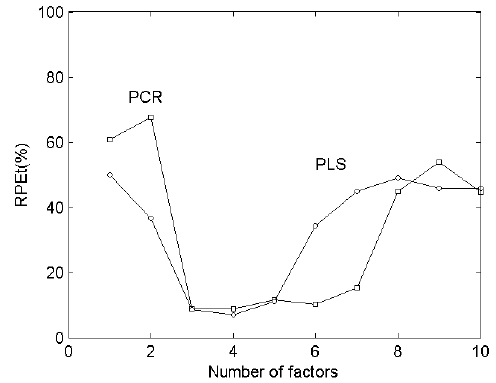
Figure 4. The relationship of PRE t and the number of factors used for PLS and PCR.